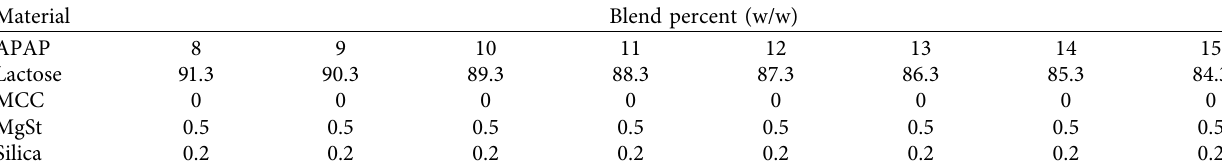
Table 1: Blend composition for APAP in